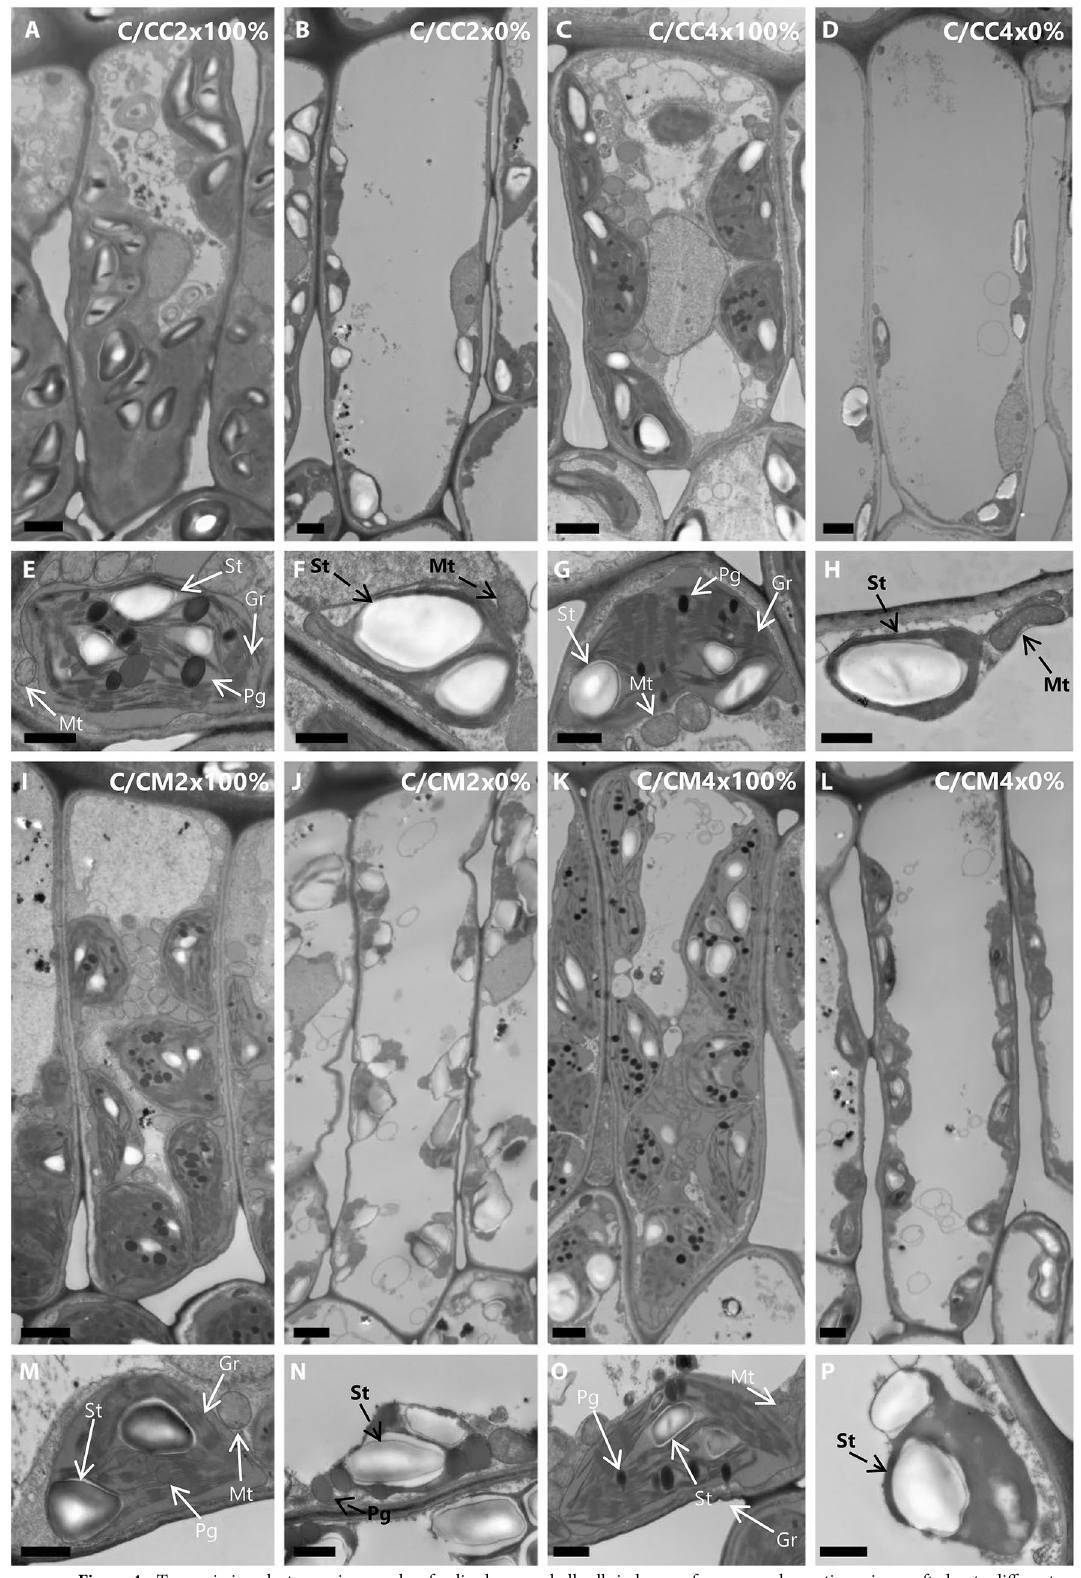
Figure 4. Transmission electron micrographs of palisade mesophyll cells in leaves of common clementine scion grafted onto different rootstocks. (( A,B,C,D,I,J,K,L ); scale bar: 5 µm) Palisade mesophyll cells and (( E,F,G,H,M,N,O,P ); scale bar: 1 µm) their respective chloroplasts in leaves of common clementine scion grafted onto diploid (C/CC2x) and doubled diploid (C/CC4x) Carrizo citrange and diploid (C/CM2x) and doubled diploid (C/CM4x) Citrumelo 4475 rootstocks grown in nutrient reference solution (100%). Scale bars for palisade mesophyll cells (5 µm) and their respective chloroplasts in leaves (1 µm) are indicated at the bottom left for each image. The significant values between rootstock ploidy level of scion/rootstock combinations and treatment are shown in bold and black with a black dotted arrow. St starch, Pg plastoglobuli, Mt mitochondria, Gr